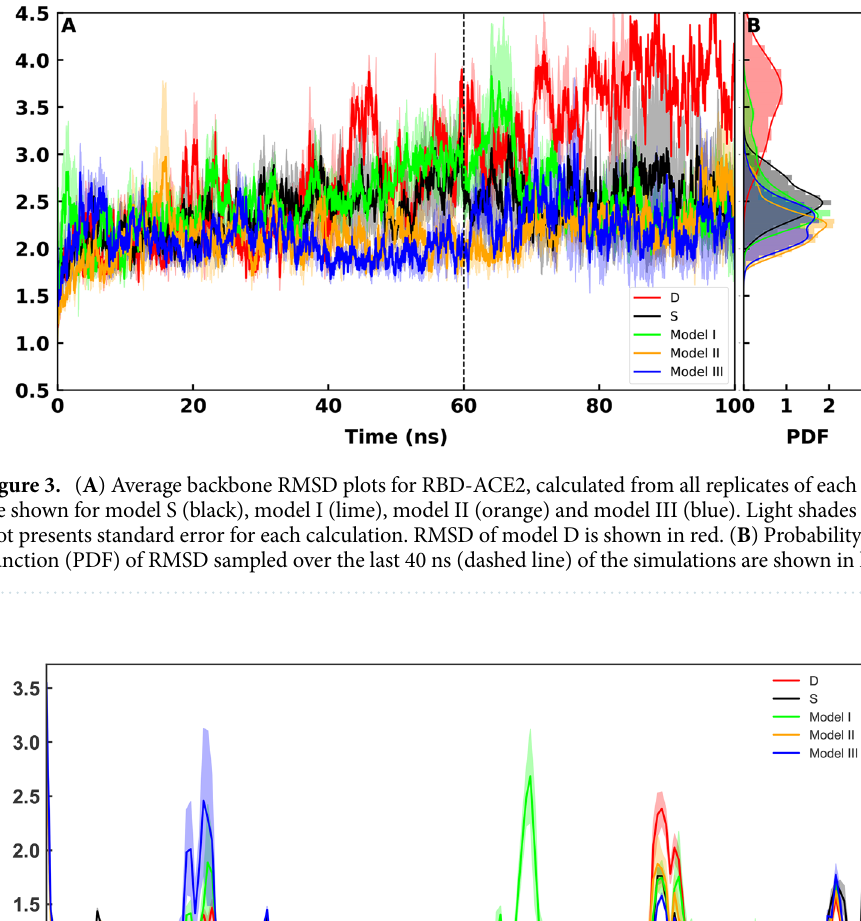
airways are often elongated oligosaccharides 25 .